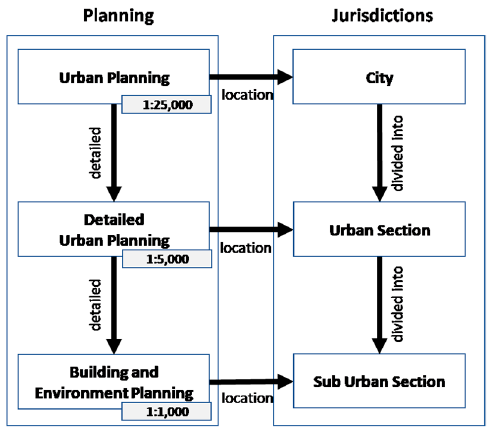
Figure 4. Relationship between Urban Planning, Detailed Urban Planning, and Building and Environment Planning according to the Minister of Public Work Decree 20 Year 2011 [67] .